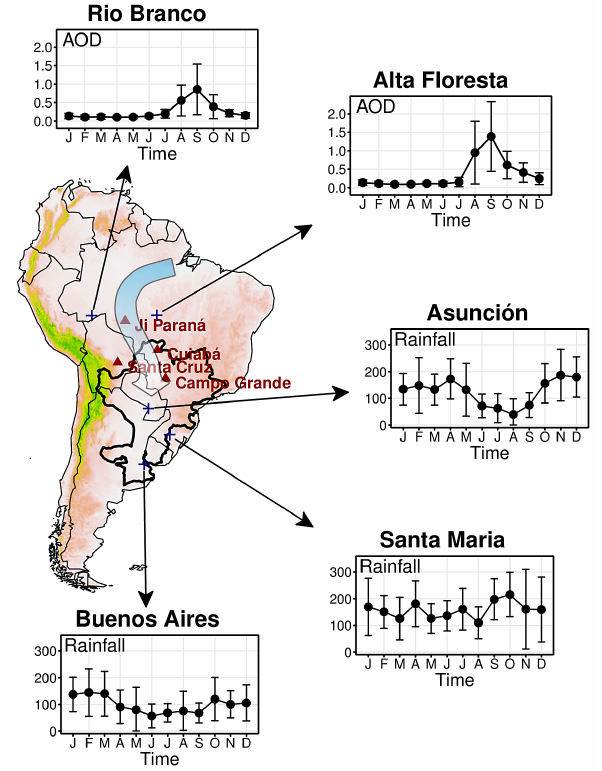
Fig. 2. Schematic illustration of this work context. The graphics are climatologies of AOD for the Rio Branco and Alta Floresta AERONET stations, and rainfall estimates from TRMM-3B42 for the cities of Asunción, Santa Maria and Buenos Aires. Ji Paraná, Cuiabá, Santa Cruz, and Campo Grande AOD stations are located in red.